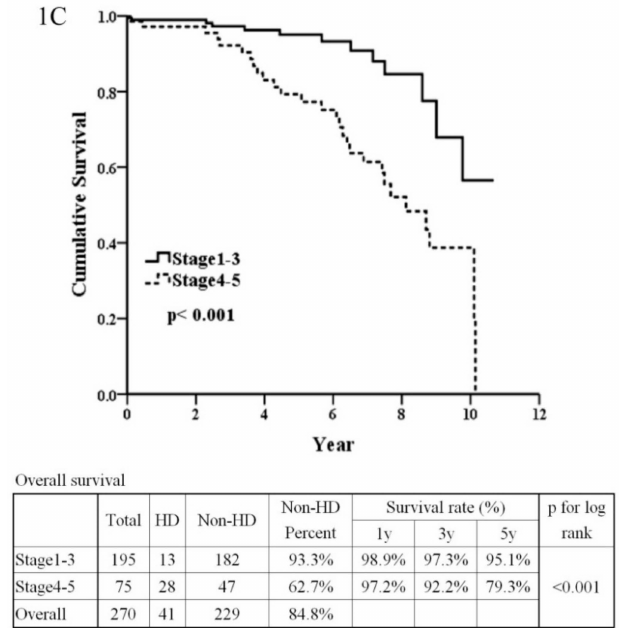
Figure 1. Patient and renal survival of IgA nephropathy according to Haas. ( 1A ) Patient survival between patients with stage 1–2 and stage 3–5 IgA nephropathy. ( 1B ) Patient survival between patients with stage 1–3 and stage 4–5 IgA nephropathy. ( 1C ) Renal survival between patients with stage 1–3 and stage 4–5 IgA nephropathy.